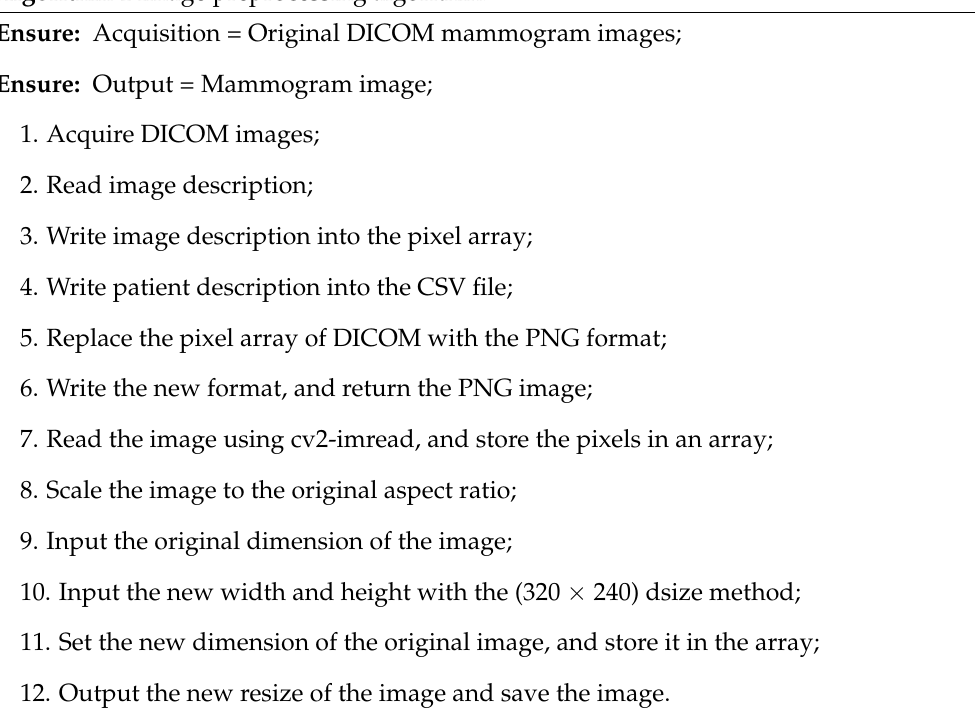
Algorithm 1 Image preprocessing